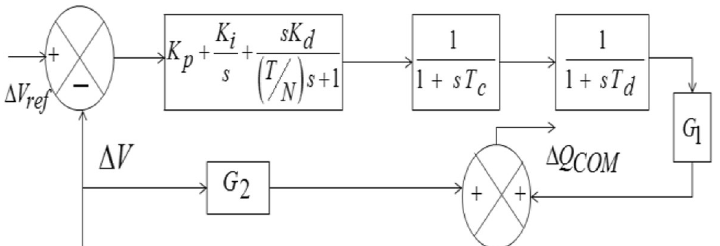
Fig. 2 Proposed STATCOM-PIDF controller